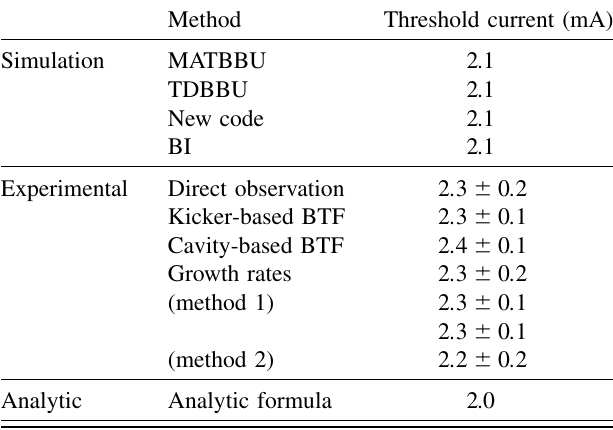
TABLE II. Comparison of experimental measurements, simu- lation results, and the analytic formula for determining the threshold